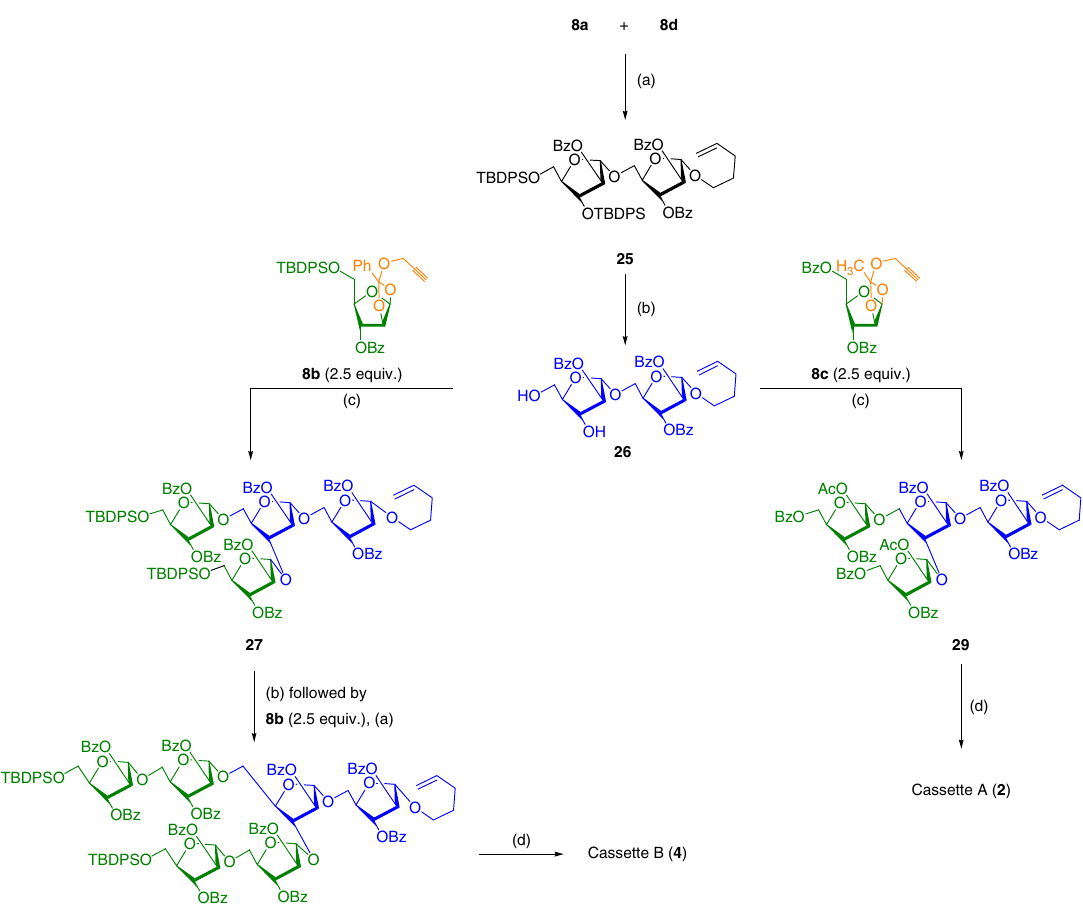
Figure 7 | Synthesis of cassettes A and B. Reagents and conditions: (a) AuCl 3 (7mol%), CH 2 Cl 2 , 4Å MS powder, 25 (cid:2) C, 2h, 81% for 25 and 50% for 28 . (b) Py (cid:2) HF, THF:Py (5:1), 0 (cid:2) C - 25 (cid:2) C, 4h, 80% for 26 and 75% for 28 . (c) AuCl 3 (7mol%), AgOTf (7mol%), CH 2 Cl 2 , 4Å MS powder, 25 (cid:2) C, 2h, 48% for 29 and 45% for 27 . (d) Br 2 , CH 2 Cl 2 , 4Å MS powder, 10min, 0 (cid:2) C followed by propargyl alcohol, 2,6-lutidine, tetrabutylammonium iodide, 0 (cid:2) C - 25 (cid:2) C, 12h, 88% for 2 and 86% for 4